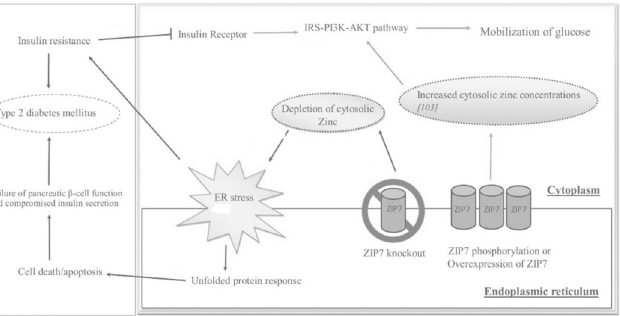
Figure 3. The effects of ZIP7 on glucose mobilization, ER stress, IR, and T2DM as depicted through various regulatory pathways. Adapted from [10].